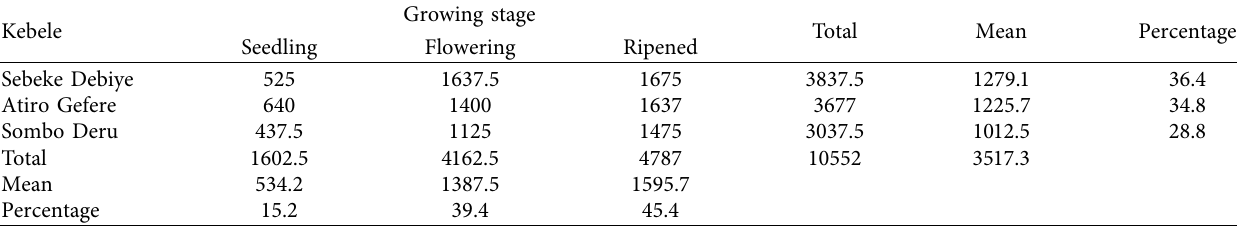
Table 6: Maize crops fed on at diferent stages in m 2 by the olive baboons.